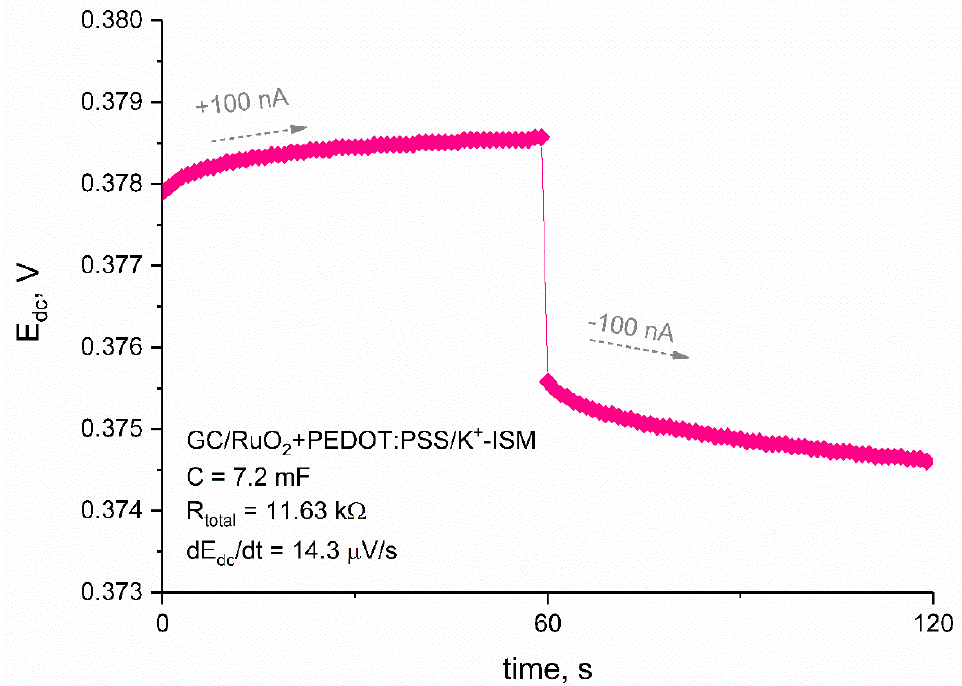
Figure 4. First two steps of chronopotentiograms recorded for glassy carbon (GC)/RuO 2 + PE- DOT:PSS/K + -ISM electrode with electrical parameter values. PEDOT:PSS/K + -ISM electrode with electrical parameter